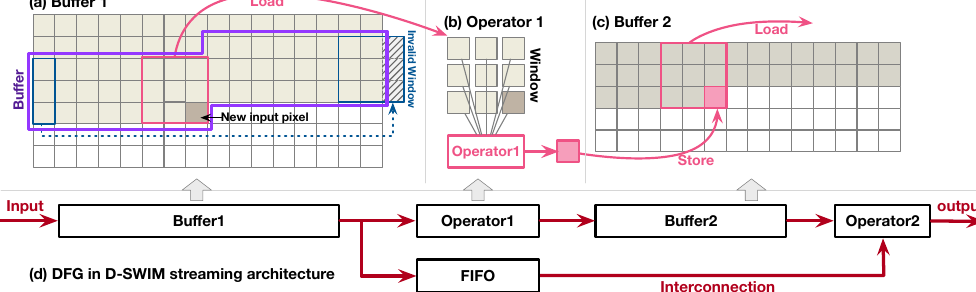
Figure 1. A streaming architecture example for image processing with a 2D pattern. The architecture has three components: buffer, operator, and